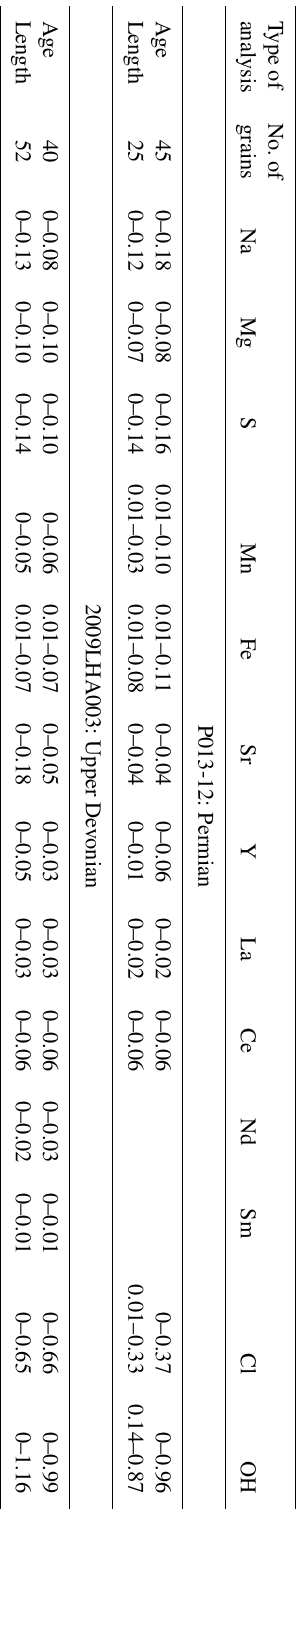
space. The initial temperature limits collapse to the bounds enveloping the acceptable thermal solutions when the model converges. The lower panels in Figs. 6 and 7 display the model and c -axis-projected measured track length distribu- tions (coloured histograms) and model retention age distribu- tions for each kinetic population. Model track length distri- butions are shown for the exponential mean (blue) and min- imum objective function (green) solutions along with the re- gions encompassing track length distributions for the 0.05 (light grey) and 0.5 (dark grey) level solutions. Model reten- tion ages represent a theoretical age for the oldest (shortest) track in each population (assumed to be ∼ 2 µm based on the shortest track ever measured; Ketcham et al., 2000) and provide an uppermost temperature and time limit for track survival. However, very short tracks are rarely observed and maximum temperatures constrained by the AFT data may be significantly lower. Two cycles of heating and cooling were used to model the post-depositional thermal history of the Permian sample based on preserved stratigraphy in the well (Fig. 6). A broad range of solutions is permitted at the 0.05 significance level due to the generally low number of track lengths for this sam- ple. Most of the lengths are in population two and therefore it has the strongest influence on the thermal history. The CRS algorithm defines a much narrower region of “good” solu- tion space at the 0.5 level, but it allows for different modes. Most of the peaks for the first heating cycle occur between 160 and 180 Ma, but two higher temperature peaks at 192 un it ) .